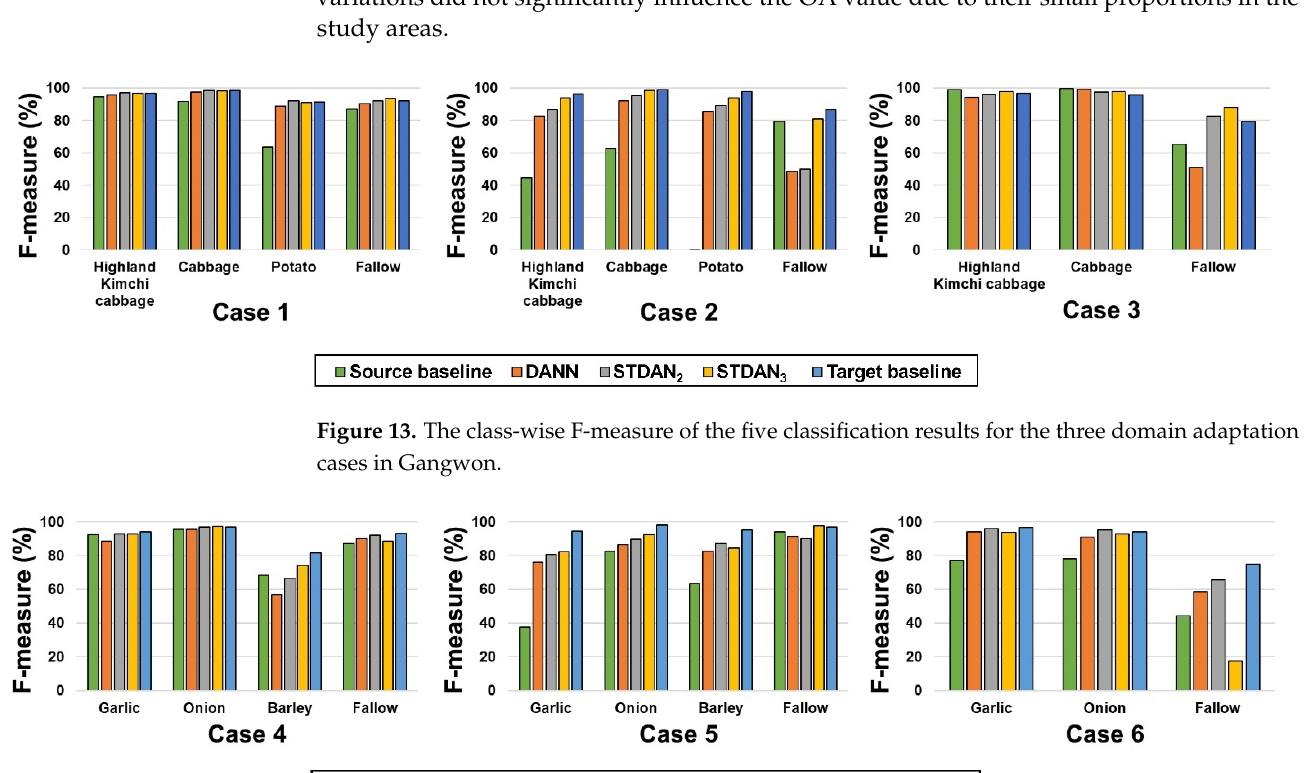
Figure 12. The overall accuracy values of the five classification results for the six domain adapta- tion cases.